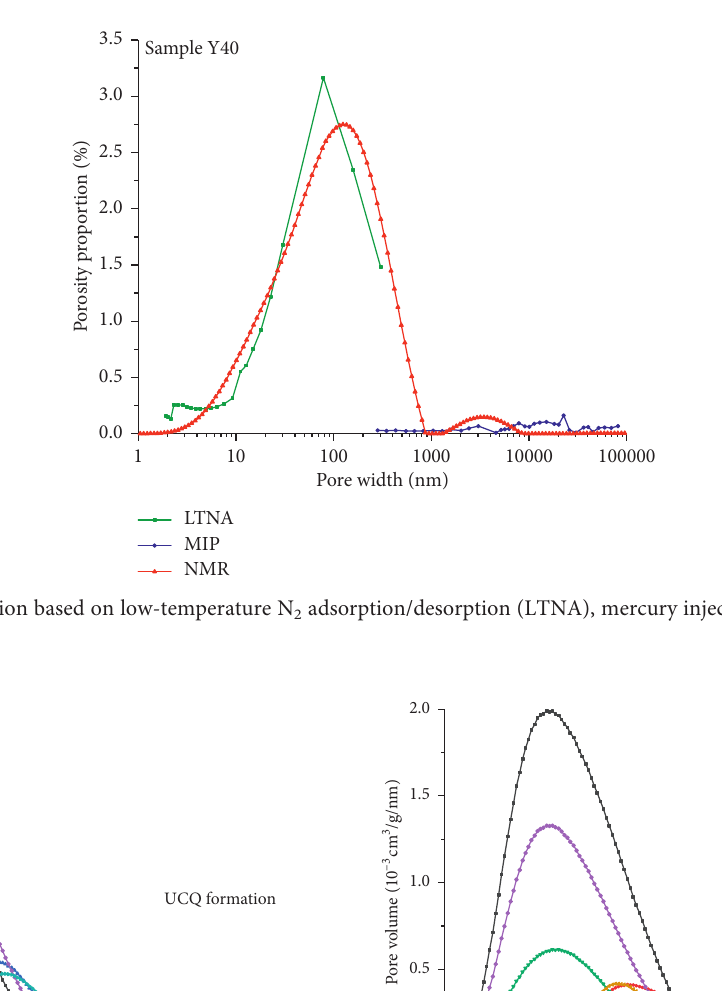
Figure 9: Plots of the pore size distribution (PSD) of collected samples derived from NMR experiments. UCQ formation (a); UCN formation (b).